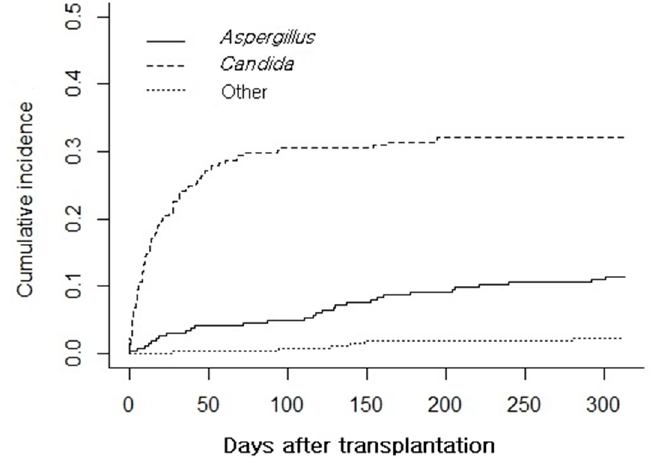
Figure 2. Cumulative incidence of fungus-positive respiratory samples stratified by fungal genus. The graph represents fungal isolation from the respiratory tract during antifungal prophylaxis. Table 1. Candida strains cultured from respiratory samples.